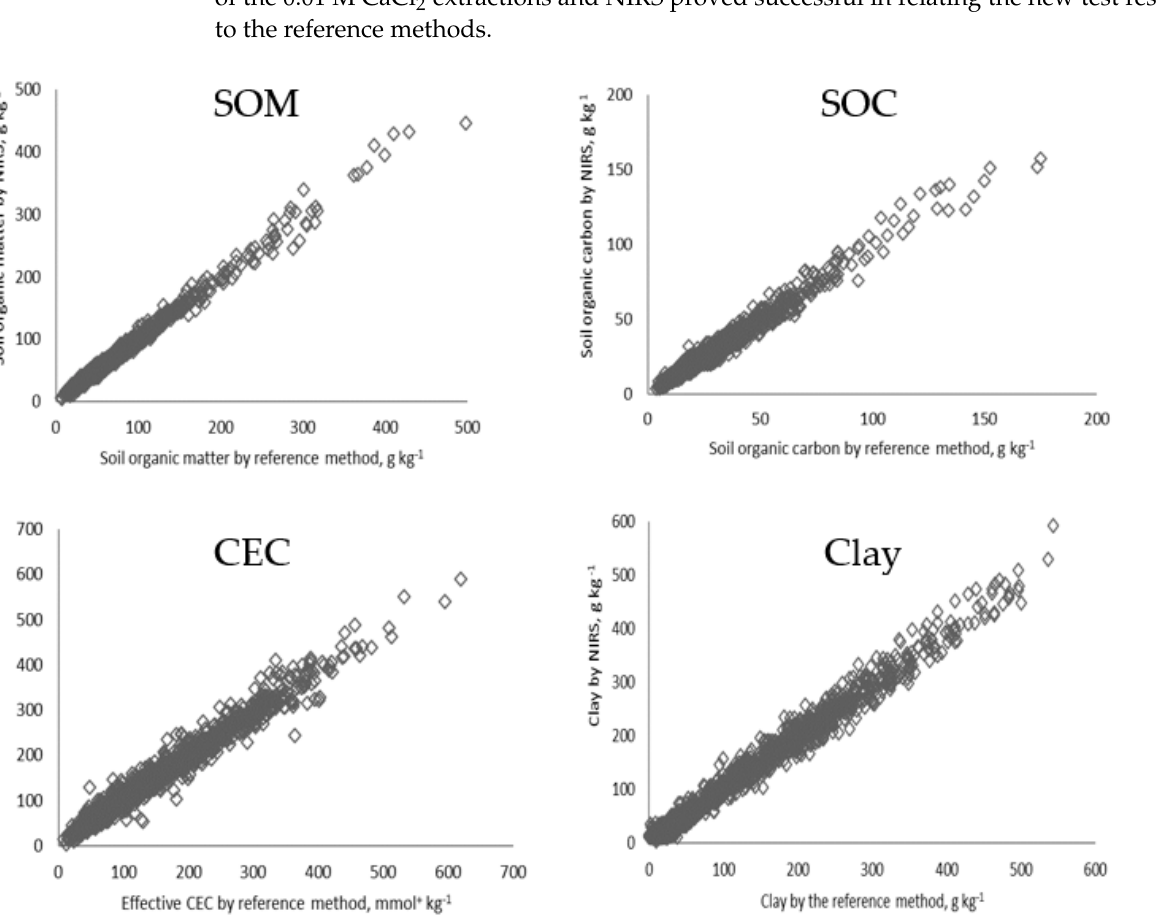
Figure 2. Scatter plots showing reference methods ( x -axes) versus NIRS ( y -axes) for soil organic matter, soil organic carbon, effective CEC, and clay % of the validation data set. Reference methods are given in Table 2, while the number of samples and statistics are given in Table 4 (and Supplementary Figure S1).